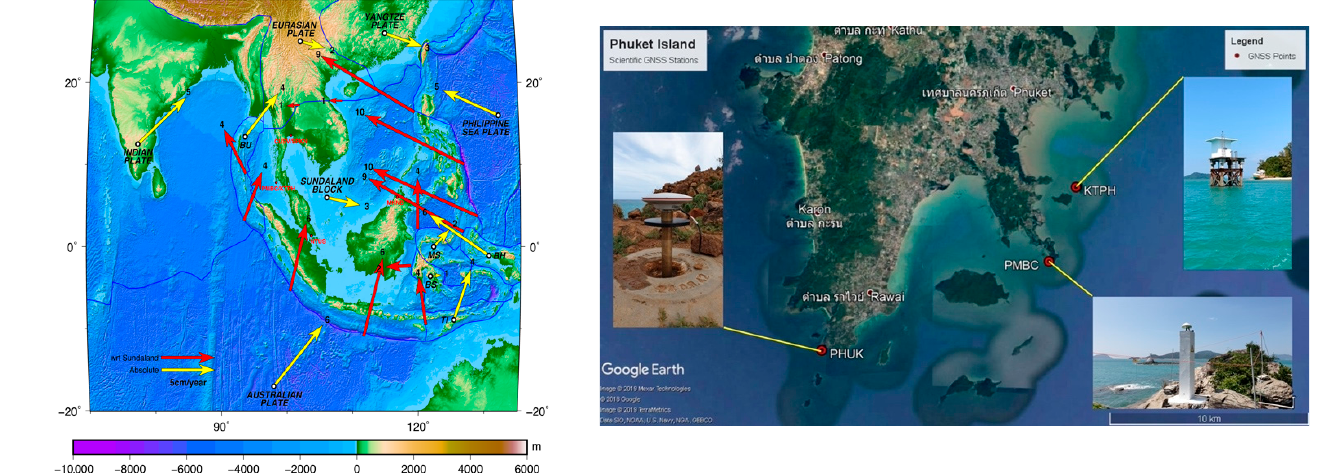
Figure 1. Left panel: locations of the PMBC and additional (TUDelft/IGS) GNSS stations CUSV, MKNB, and NTUS used in the GPS data analysis (in red) along with the estimated absolute and relative velocities (respectively in yellow and red and in cm/yr) of plates and main blocks surrounding the Sundaland (SU) plate. The approximate plate boundaries (blue lines) are based on Bird [6]. The relative velocities with respect to SU, given at selected locations, were calculated from Morvel56-NNR [7]. The absolute velocities (IGS08/ITRF2008) are based on the SU motion from Mustafar et al. [8] (~3 cm/yr in ESE direction) and the Morvel56-NNR relative to SU plate vectors relative to Sundaland. The major sources of geophysical processes on SU are the converging motions of the Australian, Indian and Philippine Sea plates and its interaction with smaller tectonic blocks (Burma (BU), Banda Sea